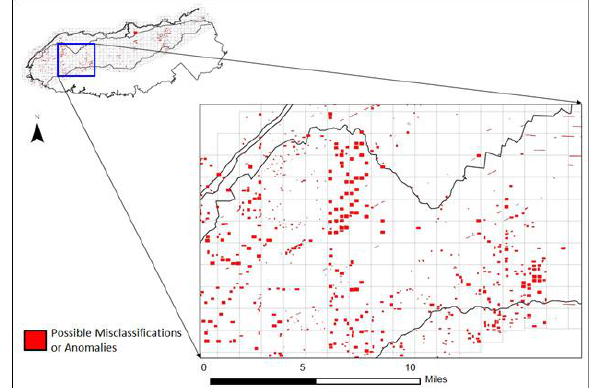
Figure 2 : QA/QC points of interest. Possible misclassifications or anomalies are marked in red. A total of 2603 regions were identified as possible misclassifications or